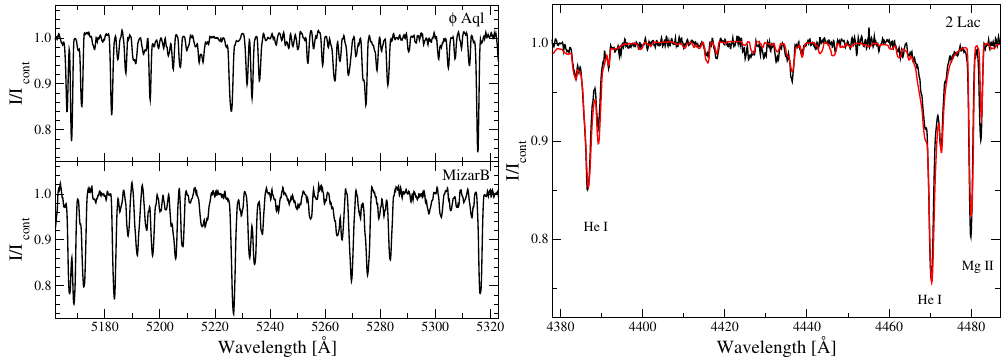
Figure 1. Left panel: Examples of the cross-correlated parts of the spectra of φ Aql and MizarB. Intensity is normalized to the local continuum. Wavelengths are shown in Å on a heliocentric scale. Right panel: Part of a spectrum of 2 Lac with a large RV separation (black line) and a model spectrum (red line) composed from two spectra calculated for T eff = 15,000 K, log g = 4.0, vsin i = 49 kms − 1 shifted by − 85 kms − 1 and for T eff = 16,000 K, log g = 4.0, vsin i = 23 kms − 1 shifted by +80 kms − 1 . The components’ contributions to the total continuum intensity at 5550 Å are 80% and 20% for the primary and secondary, respectively. The modeling is described in